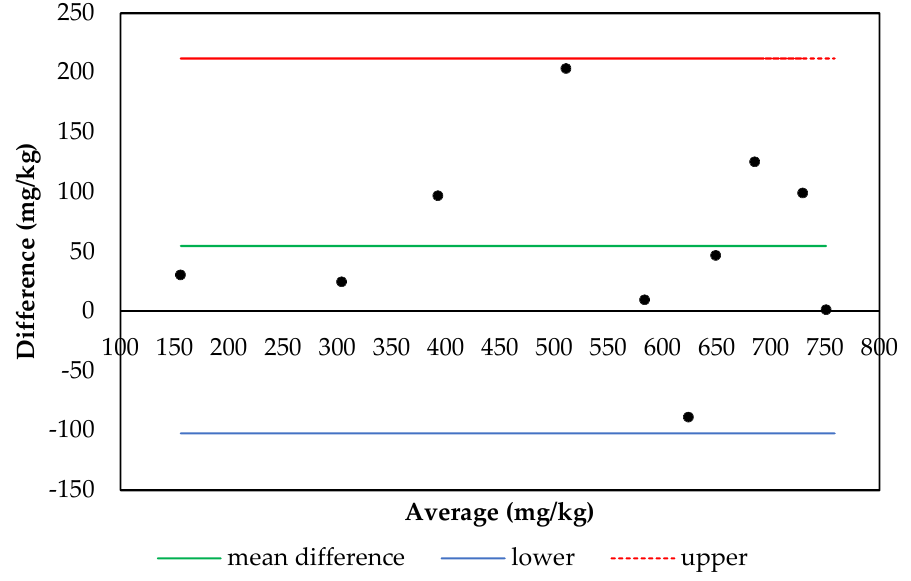
Figure 5. Bland–Altman analysis of agreement between Au measurement using XRF and AAS (mg/kg).